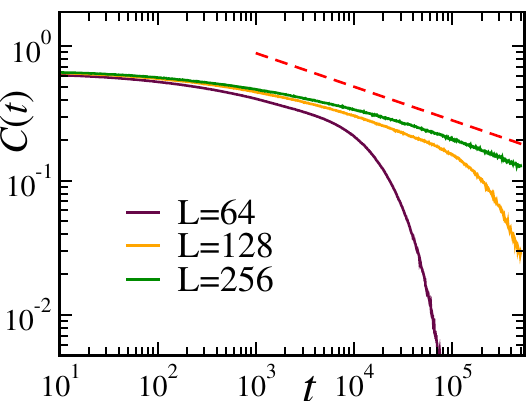
Figure 7: Numerical simulation of the colloid and the Rouse polymer model (see Fig. 6) in spatial dimension d = 1: Stationary auto-correlation function C ( t ) of the position of the colloidal probe as a function of the time-difference t at the bulk critical point r = 0 for various values of the lattice size L . The dashed line indicates the algebraic decay t − 1 / 4 predicted by the analytical perturbative calculation. Here the colloid radius R is set to R = 4 and the coupling strength λ = 0.5, with all the remaining parameters set to